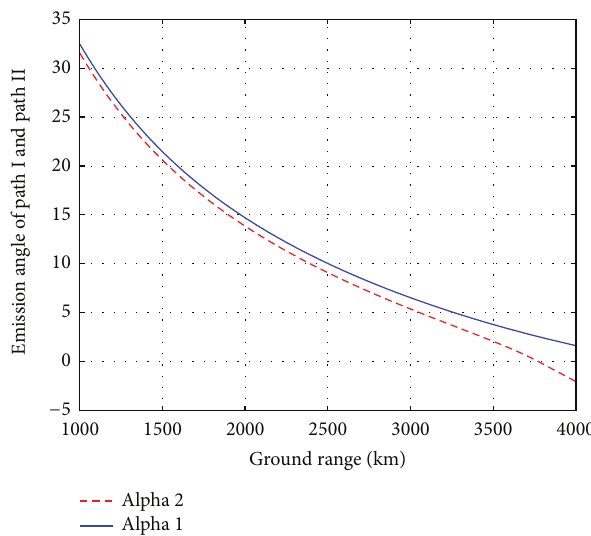
Figure 16: The curve of the emission angles 𝛼 1 and 𝛼 2 changing with the ground distance.